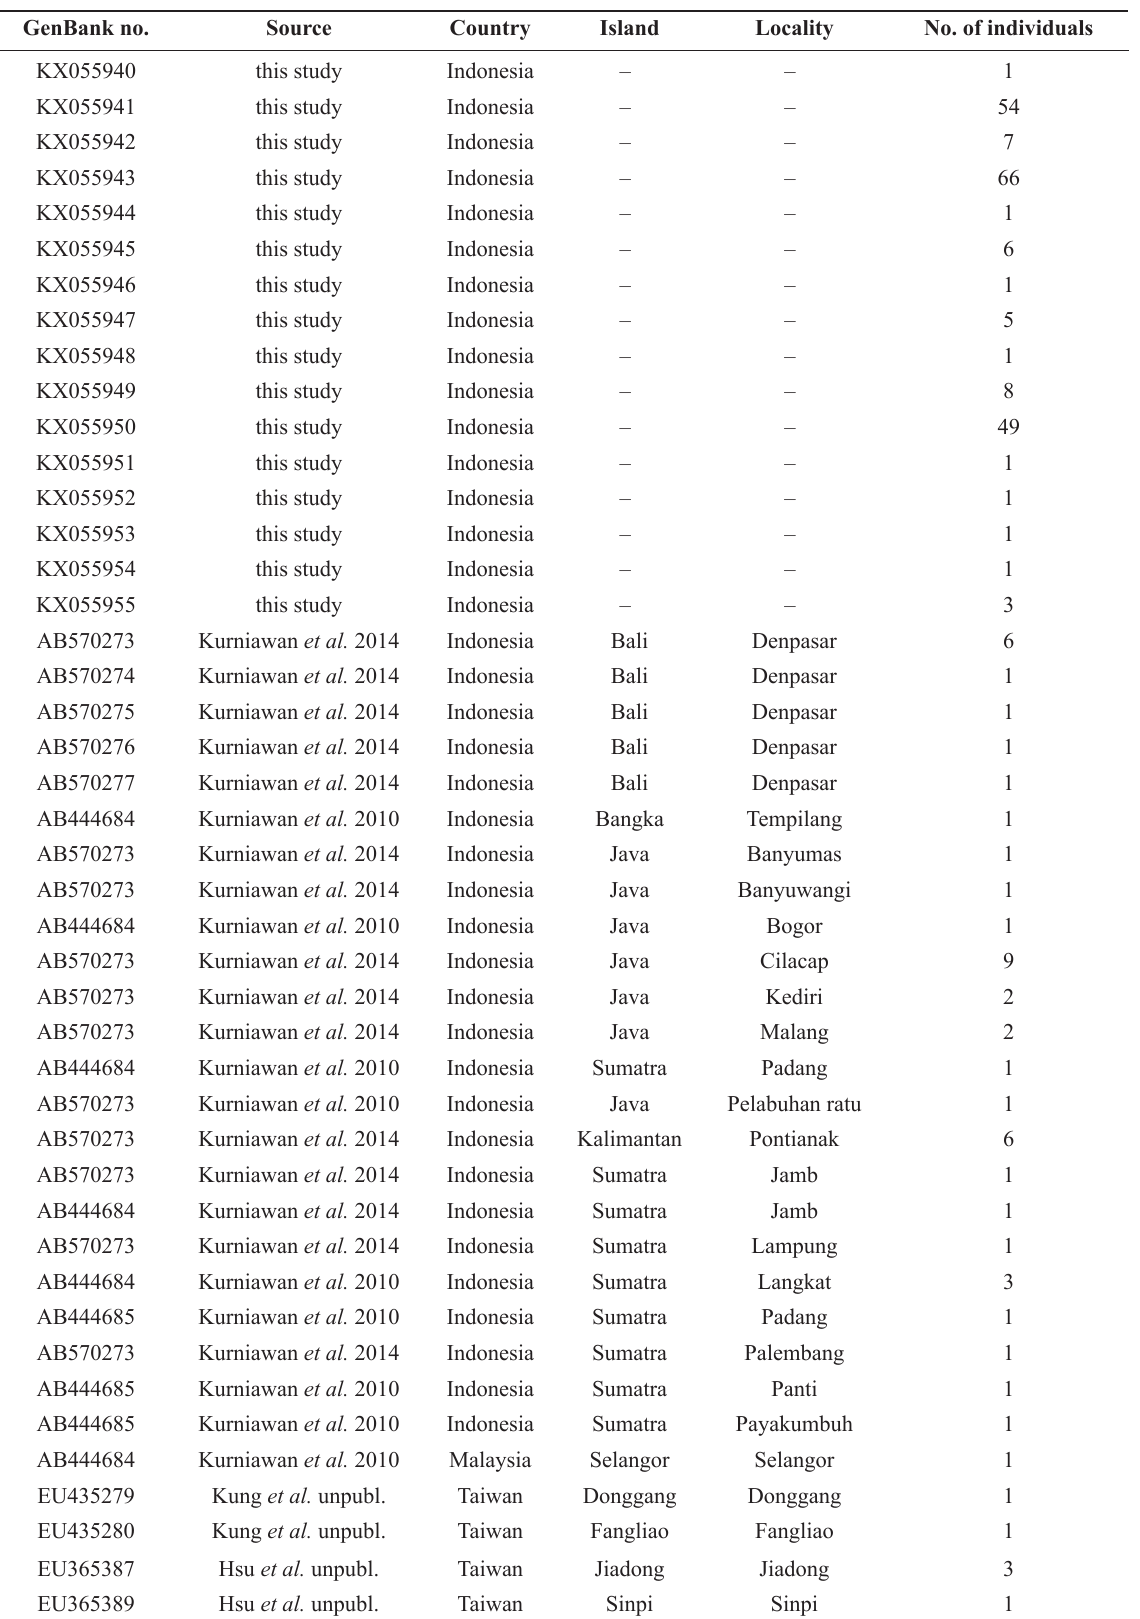
Table 2. List of specimens of Fejervarya cancrivora used in our phylogeographic analysis. GenBank